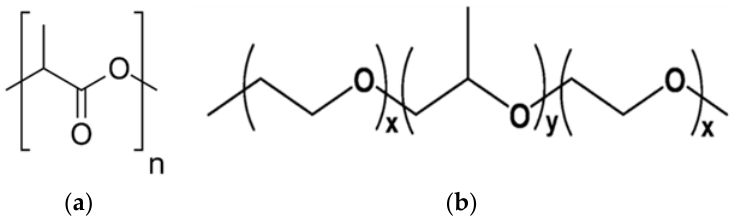
Figure 1. Chemical structures of PLA and PEG– b –PPG– b –PEG block copolymer.